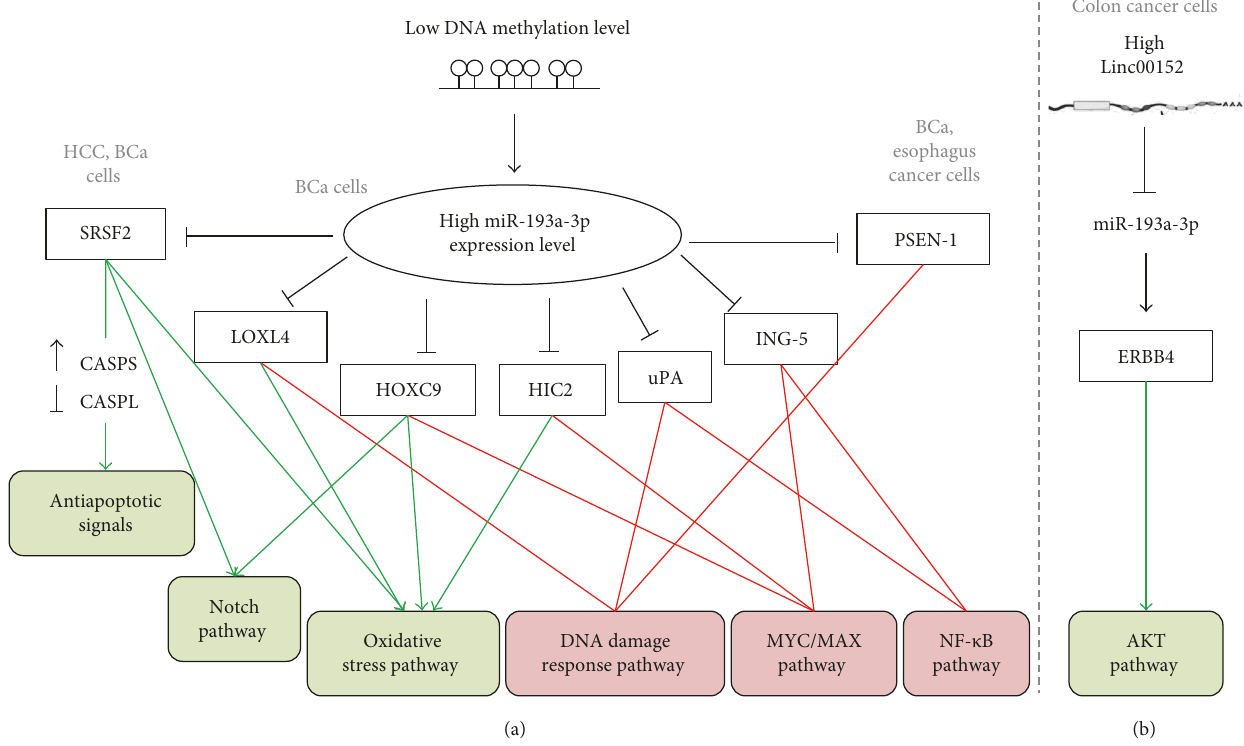
Figure 3: Proposed model for the role of miR-193a-3p in the regulation of the chemoresistance in di ff erent cancer cell lines. (a) Involvement of high miR-193a-3p expression level in chemoresistance in HCC cells, BCa cells, and esophageal cancer cells. (b) Low levels of miR-193a-3p are involved in resistance to oxaliplatin in colon cancer cells. Altered expression of miR-193a-3p will adversely a ff ect immediate targets indicated inside black boxes. In turn, these targets will a ff ect several downstream pathways with green arrows and red lines representing functional activation and repression,